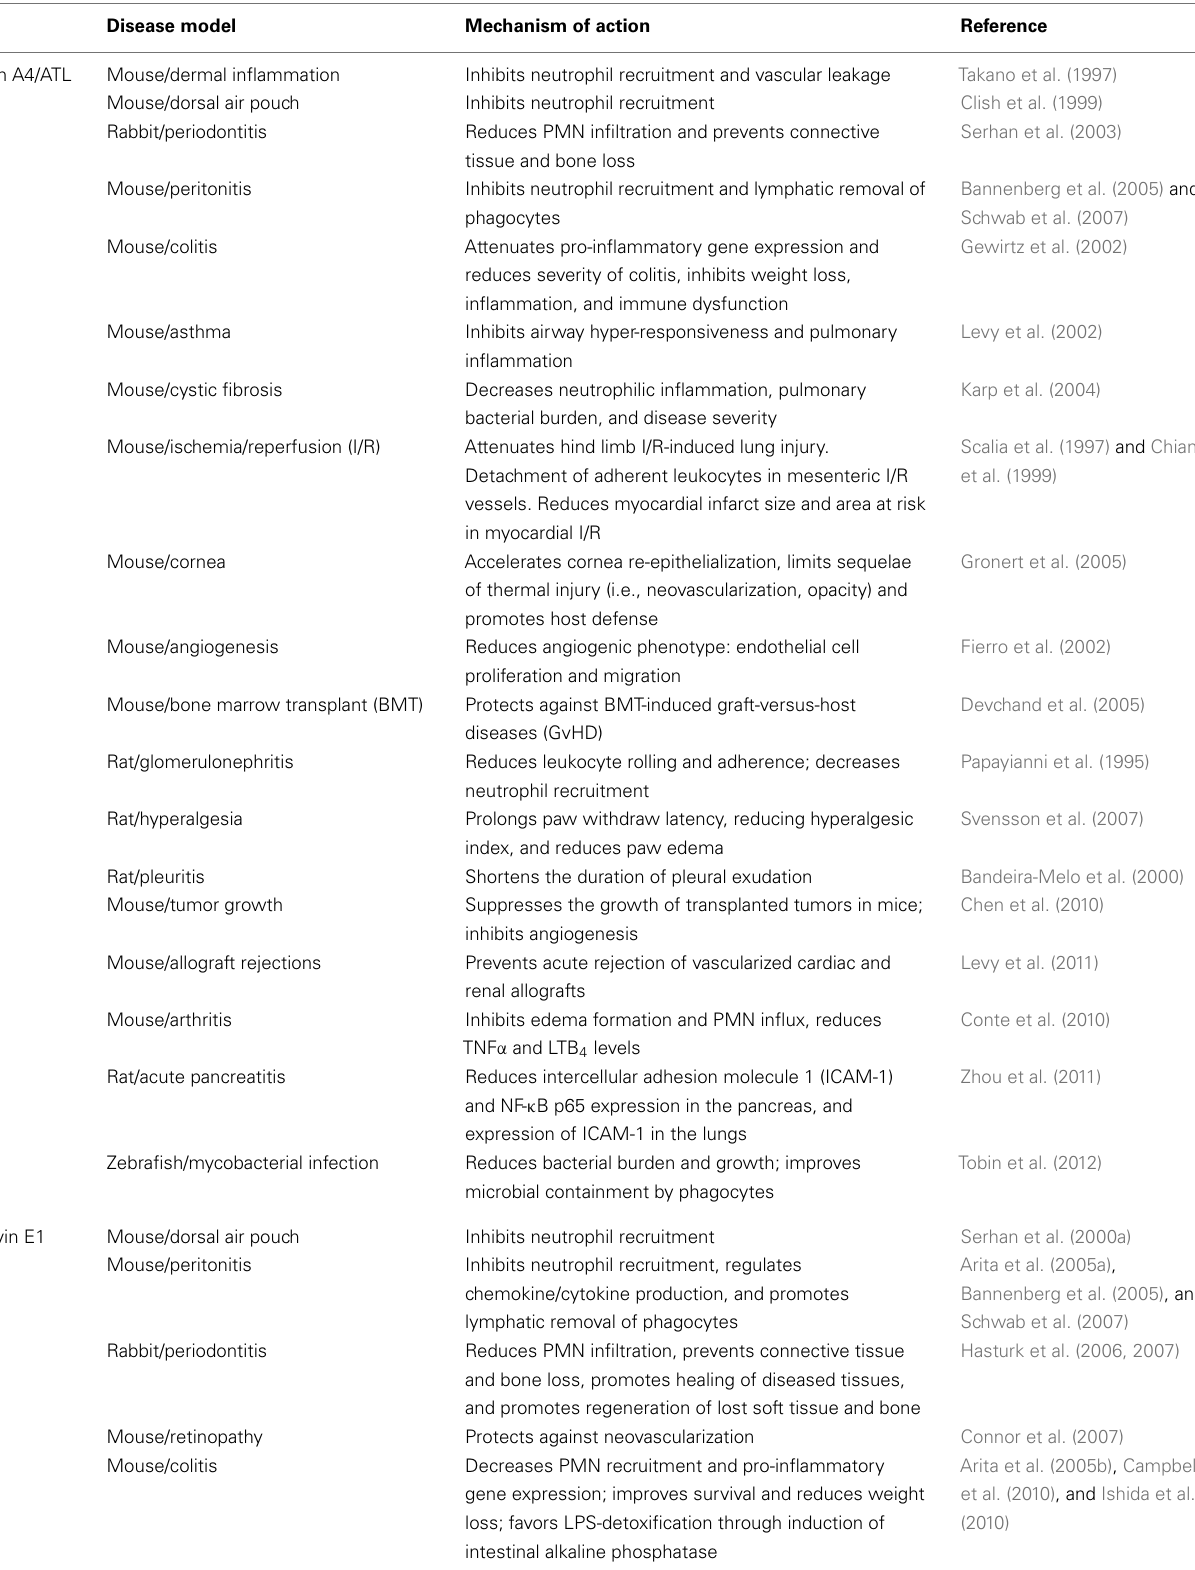
Table 1 | Bioactions of